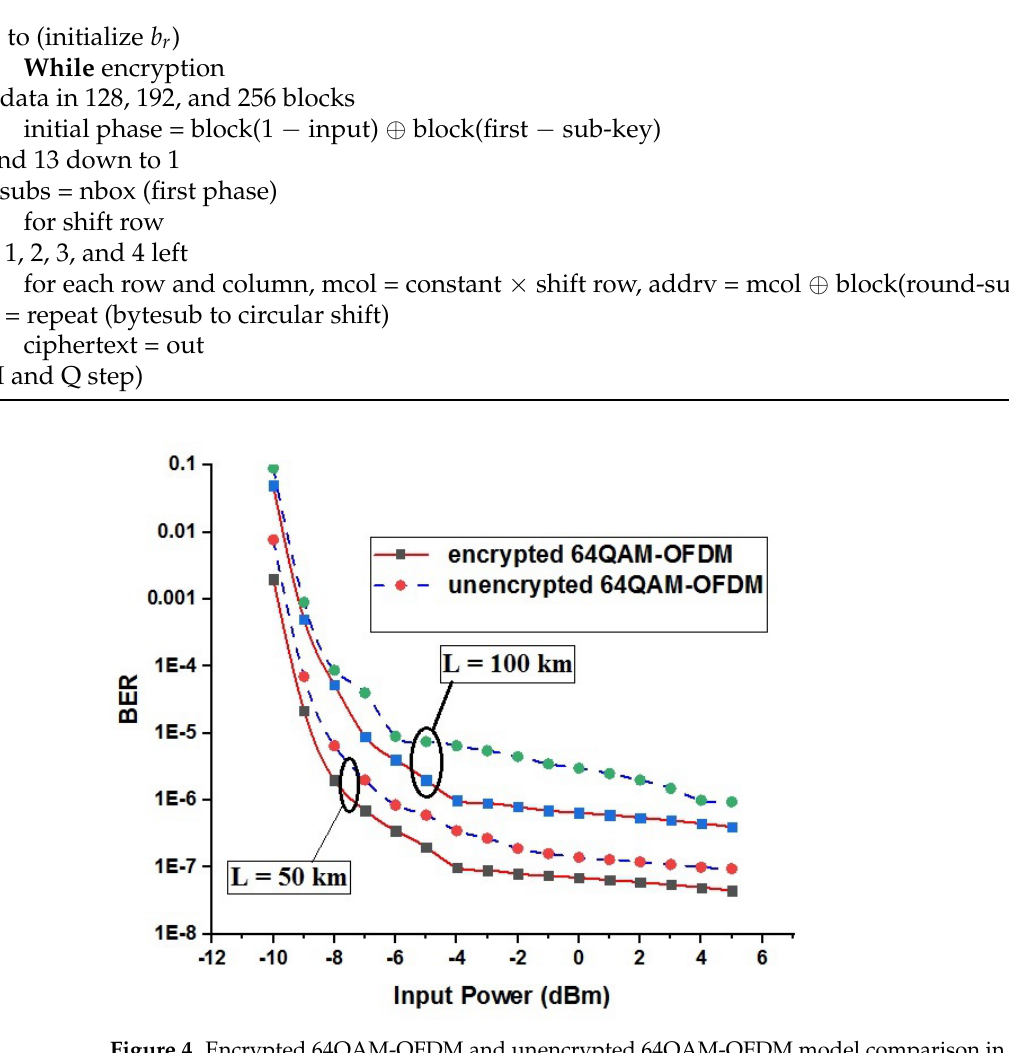
Figure 4. Encrypted 64QAM-OFDM and unencrypted 64QAM-OFDM model comparison in terms of input power and BER at 50 and 100 km